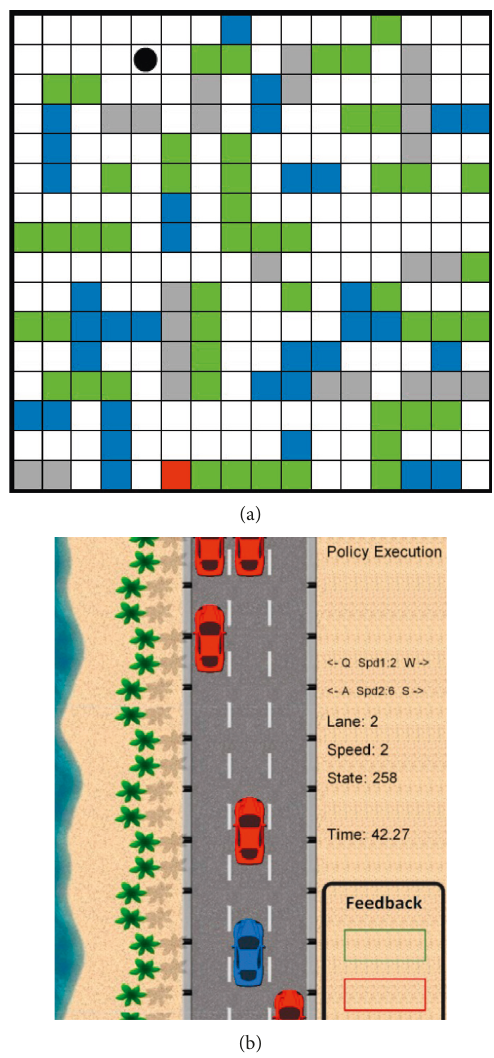
Figure 2: (a) Grid world navigation domain. The white, blue, green, gray, and red cells depict the ground, puddle, grass, obstacle, and goal, respectively. The black circle represents the learner robot. (b) A snapshot of our highway car driving